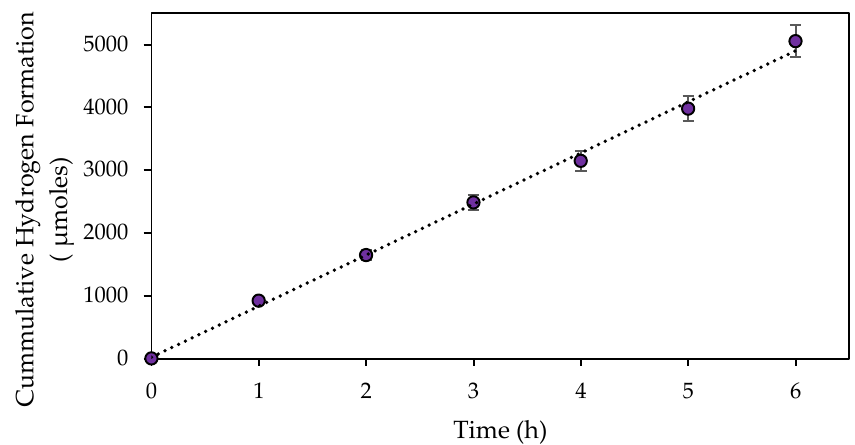
Figure 2. Cumulative formed hydrogen obtained using Pd-TiO 2 -nUV . Conditions: photocatalyst concentration: 0.15 g/L, 2.0 v / v % ethanol.